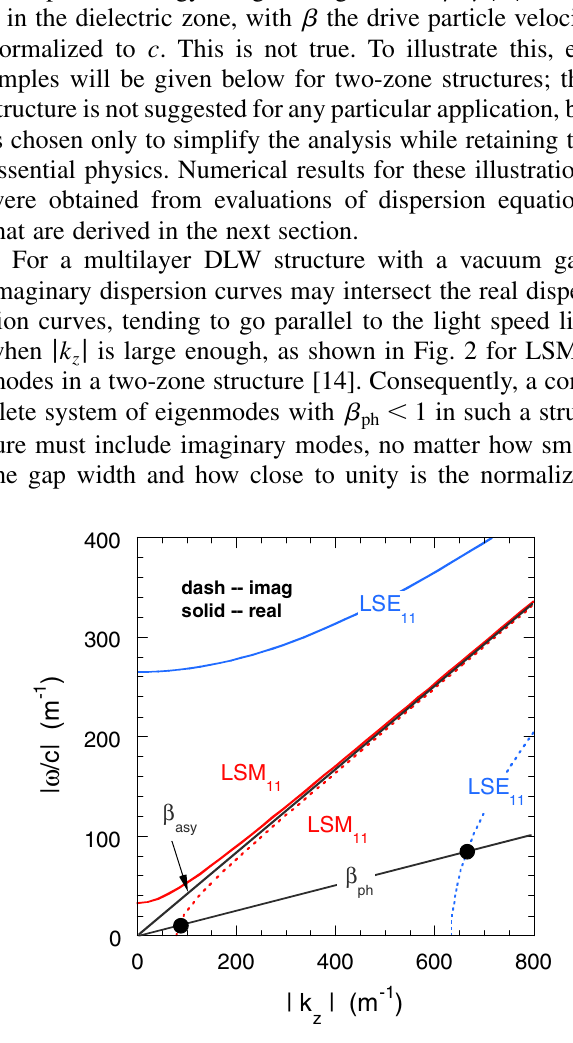
FIG. 1. (Color) Real and imaginary LSM dispersion curves for a single-zone dielectric-filled rectangular waveguide, of which the width is 5 mm and the height is 40 mm, (cid:4) 5 : 7 and (cid:1) (cid:4) 1 . It is seen that the real and imaginary with " r r dispersion curves are located in separate sides of the asymptotic . The dots on the equiphase velocity line (cid:3) line (cid:3) asy to modes with imaginary eigenvalues.